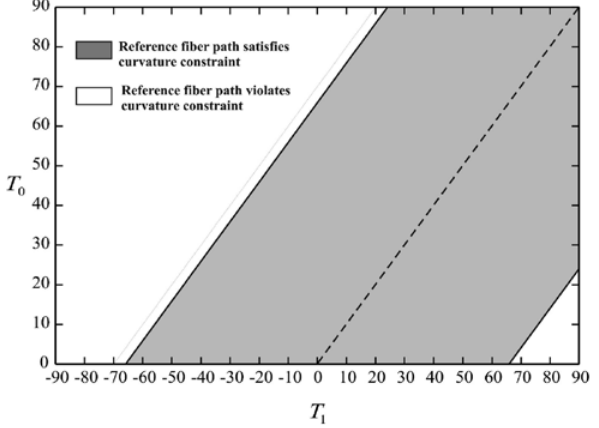
layer with shifted curvilinear s